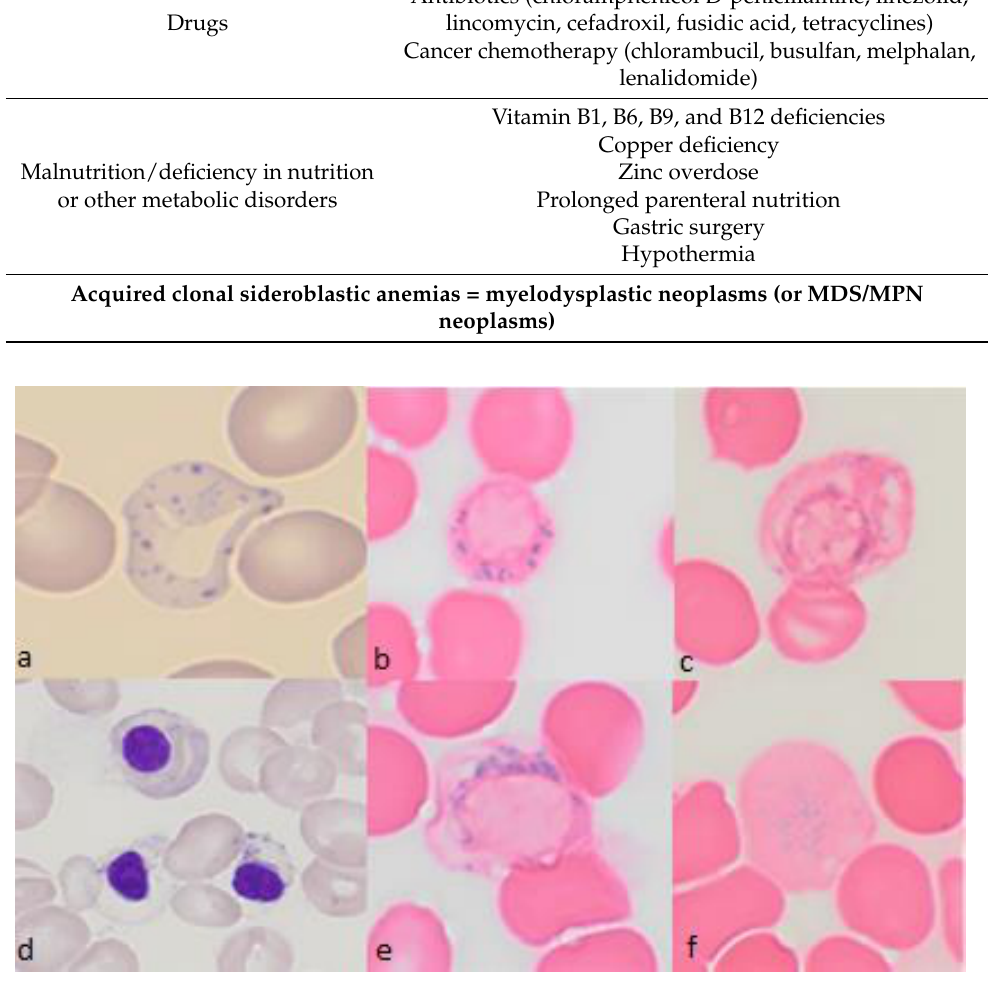
Figure 5. Representative bone marrow smears from a patient treated with lenalidomide ( a ) Peripheral blood smear showing hypochromic red blood cells with multiple basophilic stippling. May-Grünwald-Giemsa (MGG). ( b , c , e ) Bone marrow smear. Perls’ stain shows ring sideroblasts with at least five positive granules disposed in a ring surrounding a third or more of the circumference of the nucleus ( d ) Bone marrow smear showing acidophilic erythroblasts with defective hemoglobinization, vacuo- lation, and erythroblasts containing basophilic stippling, MGG. ( f ) Bone marrow smear. Perls’ stain shows siderocytes. All magnifications × Table 3. Classification of acquired sideroblastic anemias.